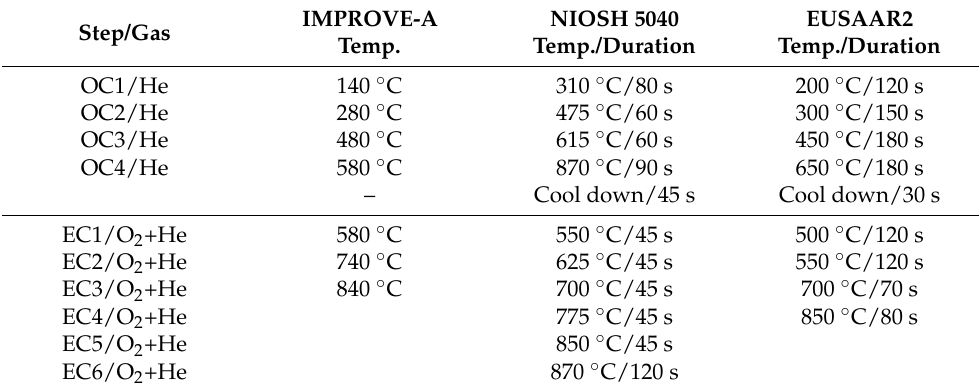
Table 1. Details of various protocols for OC/EC analysis